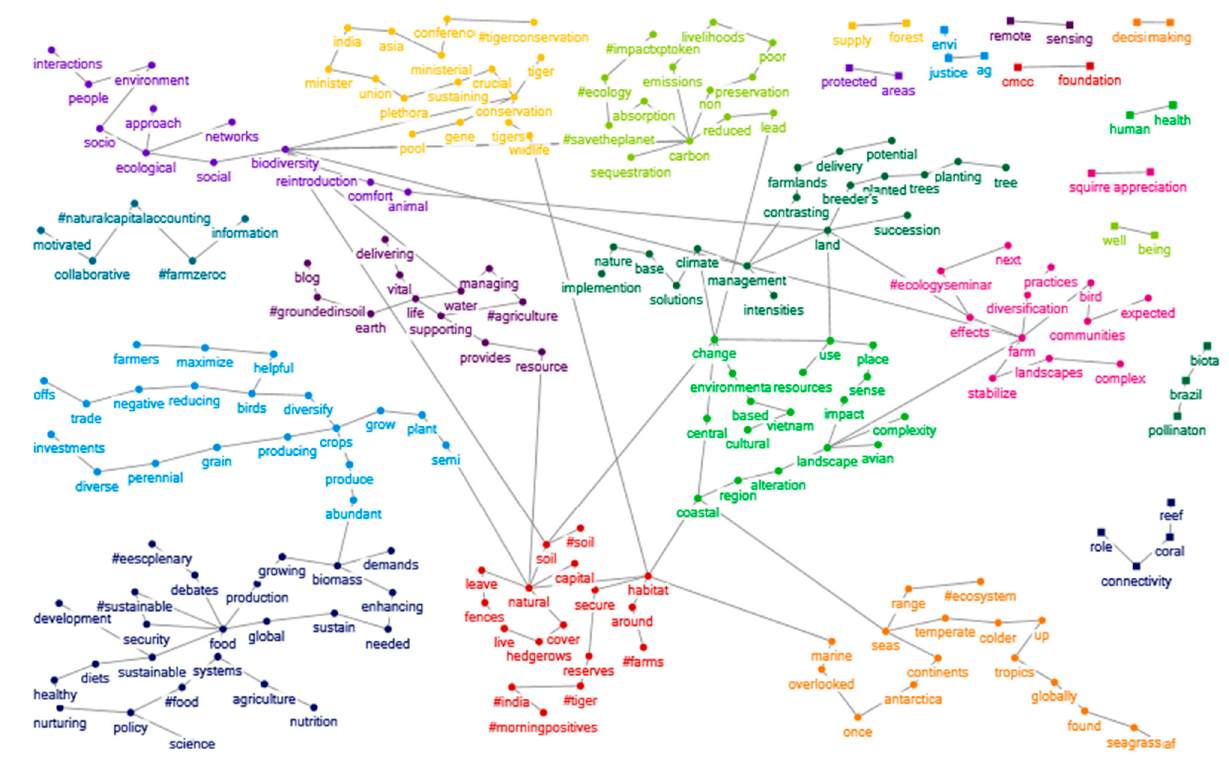
Figure 5. Semantic networks on tweets about ecosystem services (25 January 2022). The different colours represent the different clusters.